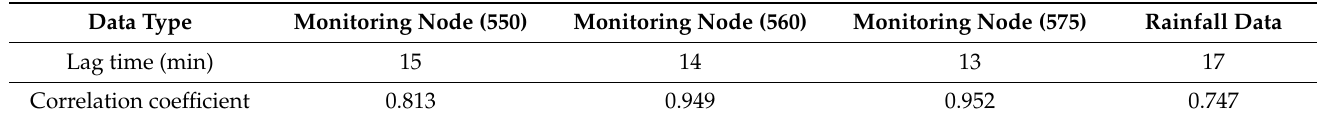
Table 4. Results of correlation analysis.